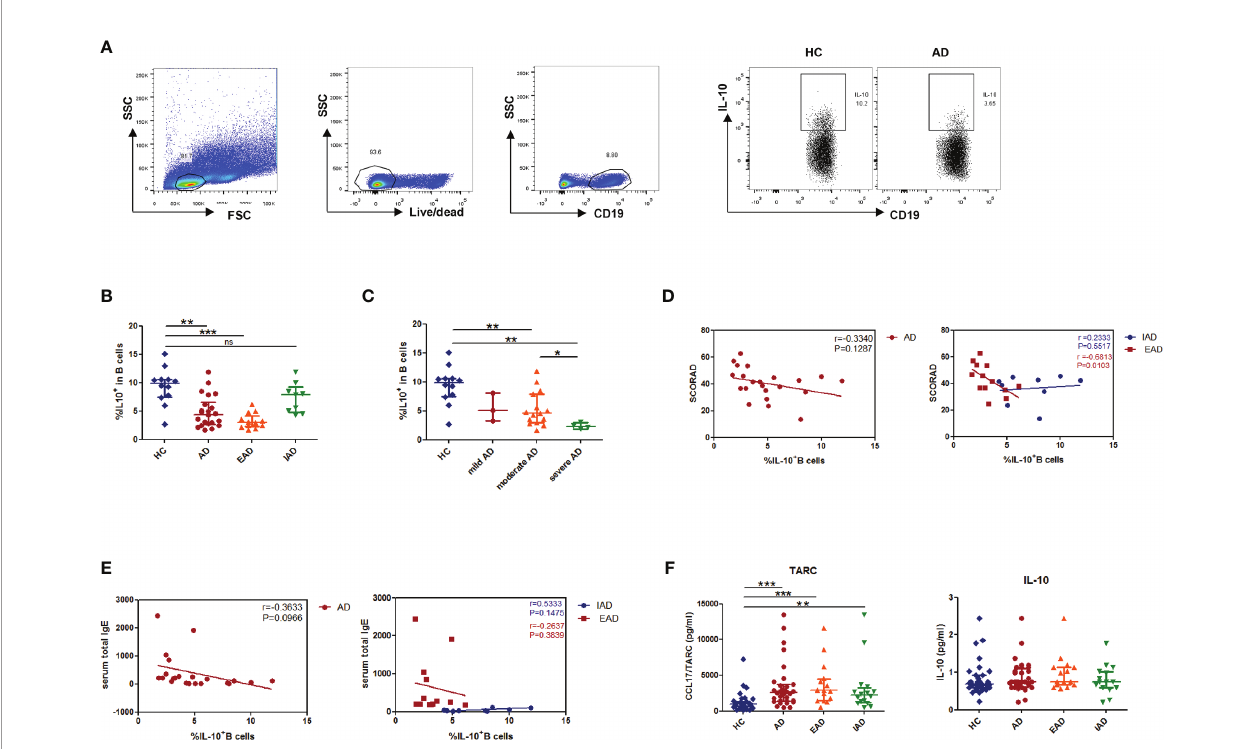
FIGURE 1 | A decreased percentage of IL-10 + B cells negatively correlates with disease severity in children with EAD. (A, B) The percentage of IL-10 + B cells in patients with EAD (n = 13) is signi fi cantly lower than that in healthy controls (n = 12), but not in patients with IAD (n = 9). (C) Patients with moderate to severe AD show a lower percentage of Breg cells than those with mild AD. (D) The percentage of Breg cells in patients with EAD correlates negatively with SOCRAD. (E) There is no signi fi cant correlation between the percentage of Breg cells and total serum IgE level in patients with EAD. (F) There is no difference between the AD and HC groups with respect to serum levels of IL-10, but there is a signi fi cant increase in serum TARC levels in the AD group [HC: n = 32; patients with AD: n = 32, including EAD (n = 16) and IAD (n = 16)]. Data are represented as median and interquartile range. *P < 0.05, **P < 0.01, and ***P < 0.001. ns, not signi fi cant (Mann-Whitney U